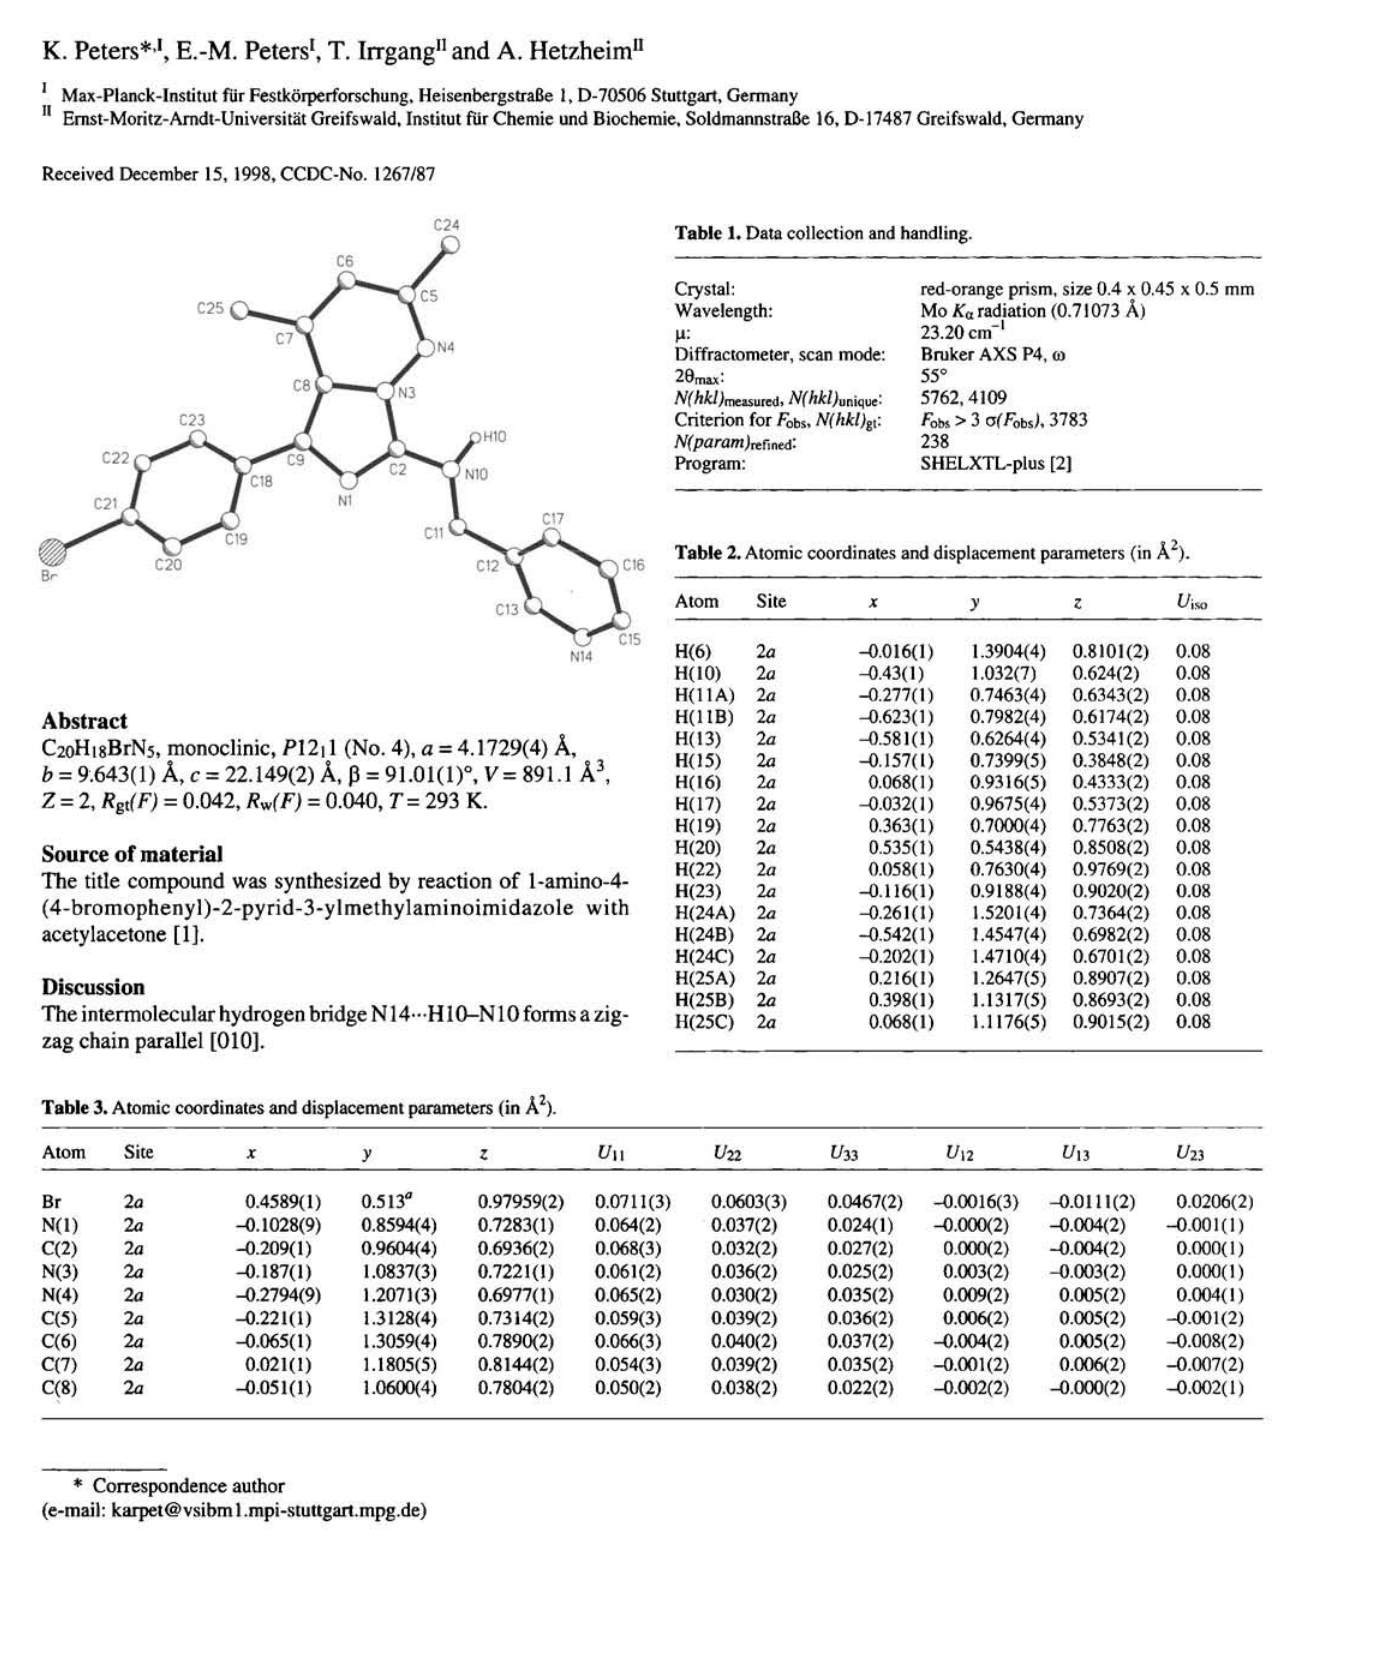
Table 1. Data collection and handling.